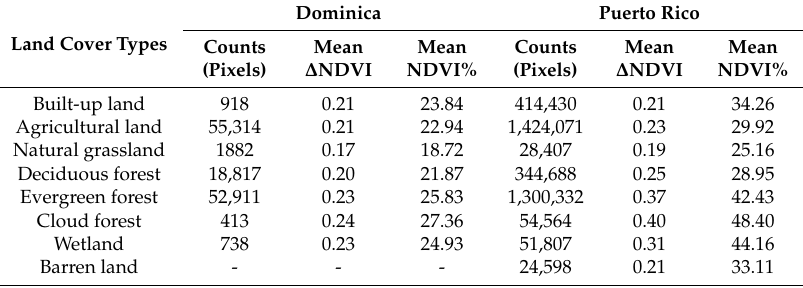
Table 6. The NDVI change statistics for different land cover types for Dominica (pre-hurricane: 09/09/2017, post-hurricane: 09/21/2017) and Puerto Rico (pre-hurricane: 09/17/2017, post-hurricane: 10/03/2017).